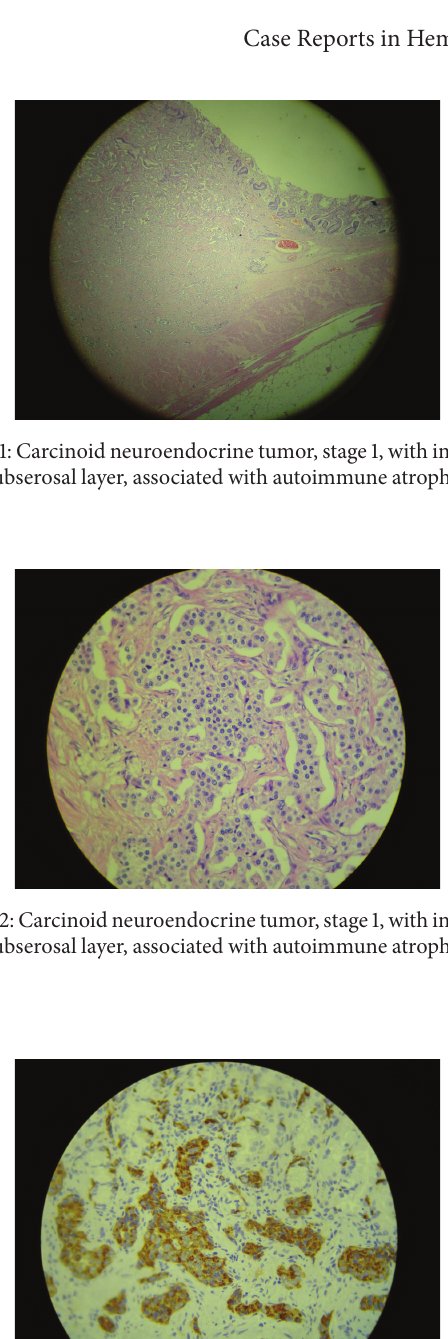
(Figure 4), positive for CD56 marker, (Figure 5), positive for CD8 marker and negative for CD4